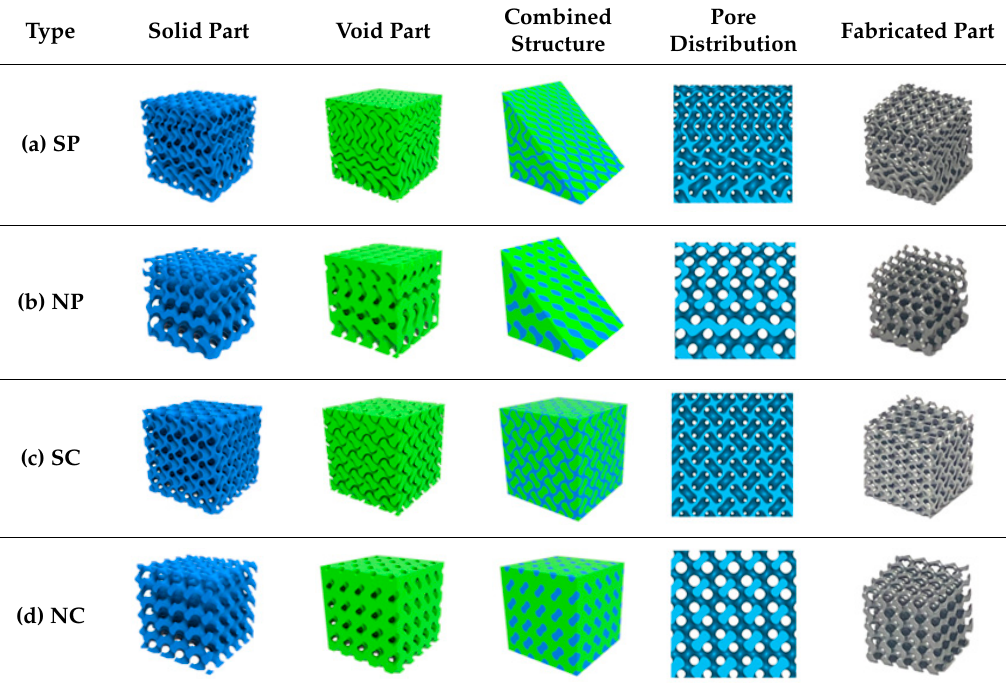
Table 1. Analysis and comparison of a sheet / network-based FGS with programmable pore sizes and constant cell size: ( a ) sheet-based FGS with programmable pore size (SP), ( b ) network-based FGS with programmable pore size (NP), ( c ) sheet-based FGS with constant cell size (SC), and ( d ) network-based FGS with constant cell size (NC). Solid Part Void Part Combined Structure Solid Part Void Part Combined Structure Pore Distribution Fabricated Part